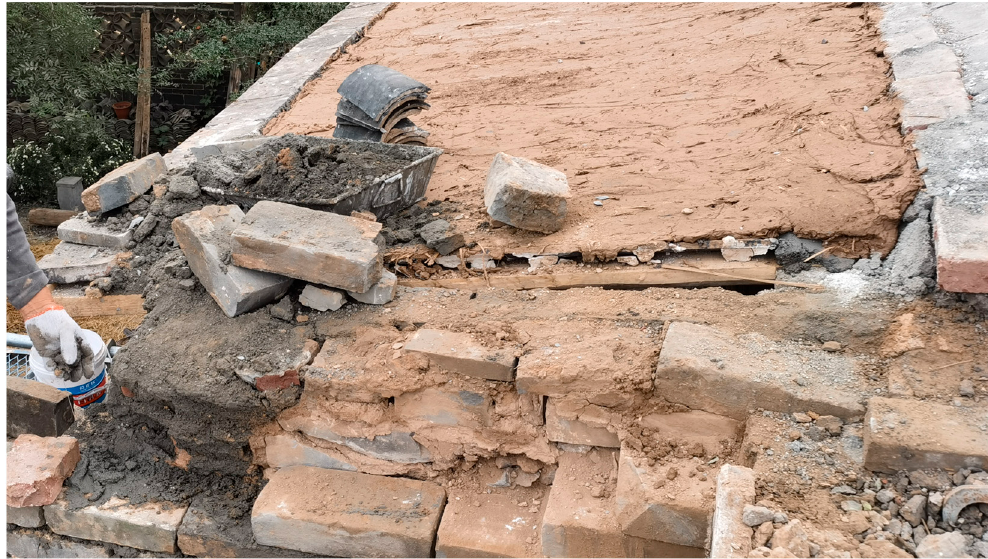
Figure 13. Thatch back (ShanBei) construction process. Photo by W. Rong.